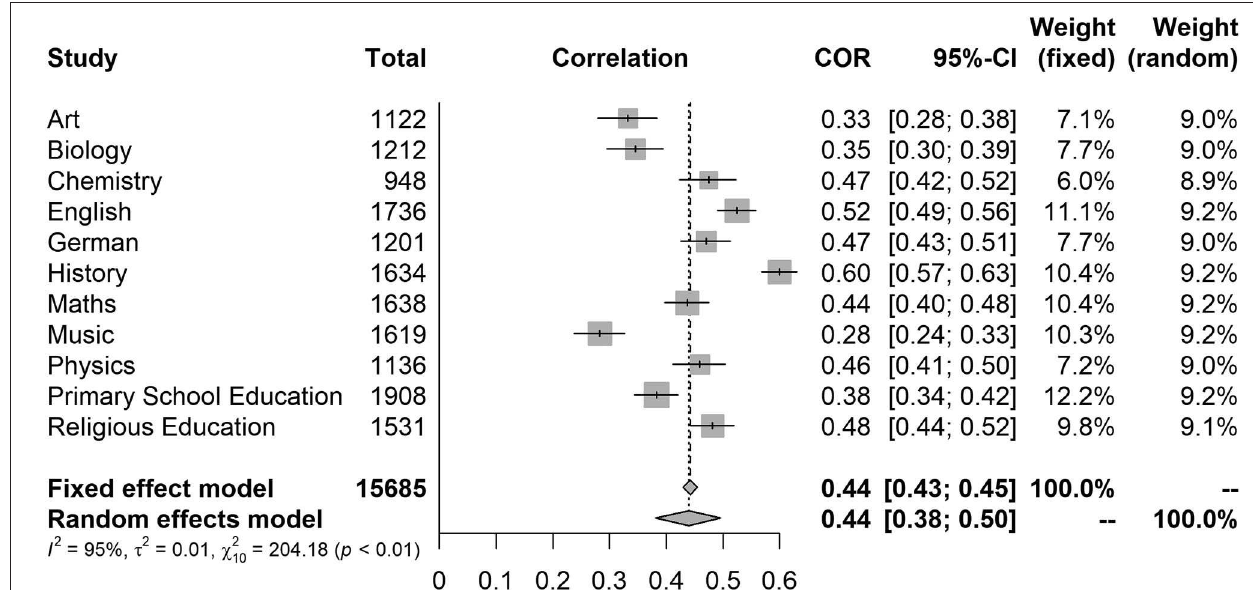
FIGURE 1 | Forestplot for the subject-specific relationships between structuredness and global rating and results of the fixed effect and random effects model.